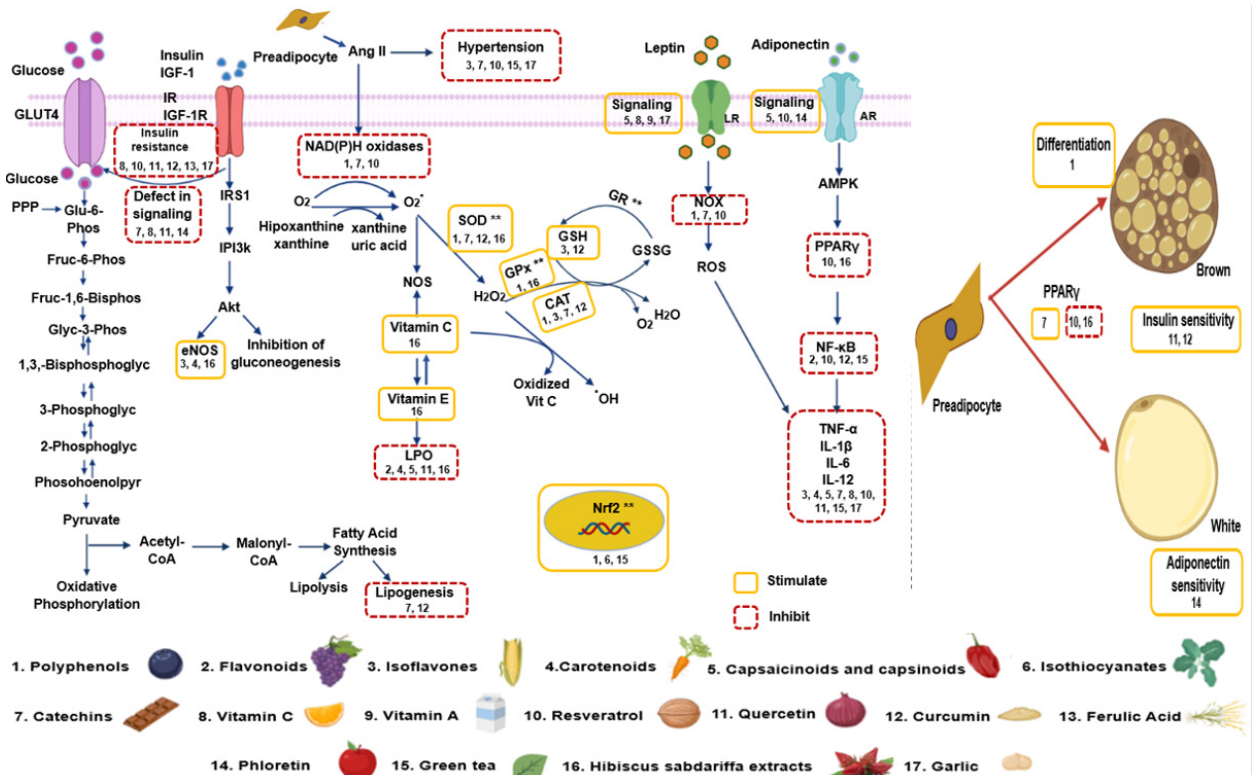
Figure 3. Summary of the interaction of antioxidant groups found in natural plants and the different metabolic pathways to induce anti obesogenic effects. The numbers correspond to the natural product and the “**” correspond to the enzymes stimulated by Nrf2. Abbreviations: Ang II = Angiotensin II, eNOS = endothelial nitric oxide synthase, H 2 O 2 = hydrogen peroxide, GLUT 4 = glucose transporter type 4, GR = glutathione reductase, GSH = glutathione, GSSG = oxidized glutathione, IGF-1 = insulin-like growth factor 1, IGF-1R = insulin-like growth factor 1 receptor, IL = Interleukin, IR = insulin receptor, IRS 1 = insulin receptor substrate 1, LR = Leptin receptor, NF- κ B = nuclear factor κ -light-chain-enhancer of activated B cells, NOS = nitric oxide synthase, NOX = nicotinamide adenine dinucleotide phosphate oxidase, O 2 − = superoxide anion, PI3k = phosphoinositide 3-kinase, PPAR = peroxisome proliferator–activated receptor, PPP = pentose phosphate patway, ROS = reactive oxygen species, SOD = superoxide dismutase, TNF- α = factor de necrosis tumoral alfa.